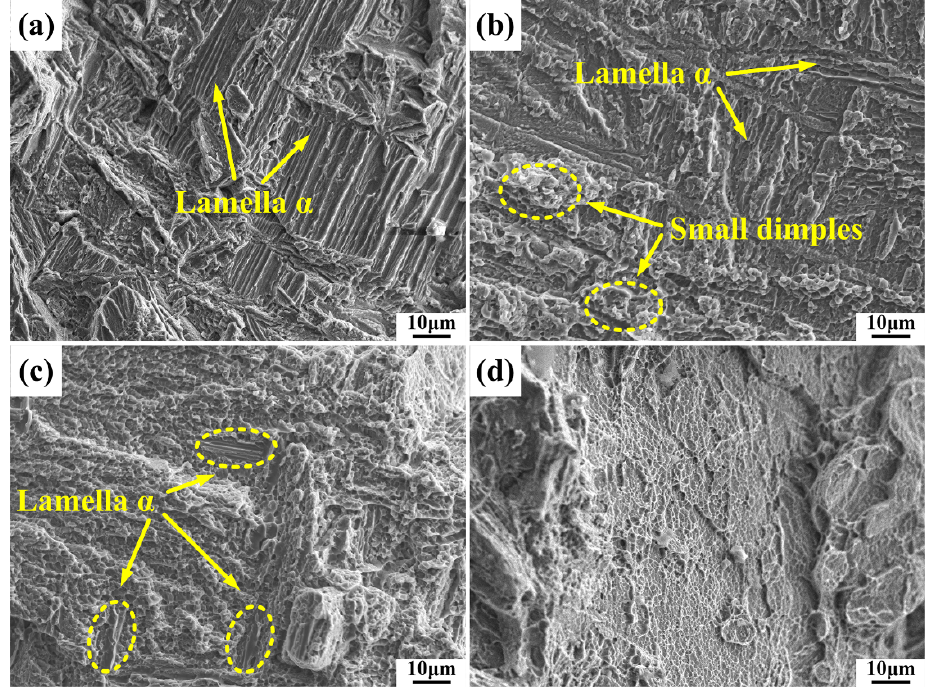
Figure 8. 25 °C fracture morphology of the initial and heat-treated DsTi700 alloy: ( a ) initial composite, ( b ) HT1, ( c ) HT3 and ( d ) HT5.